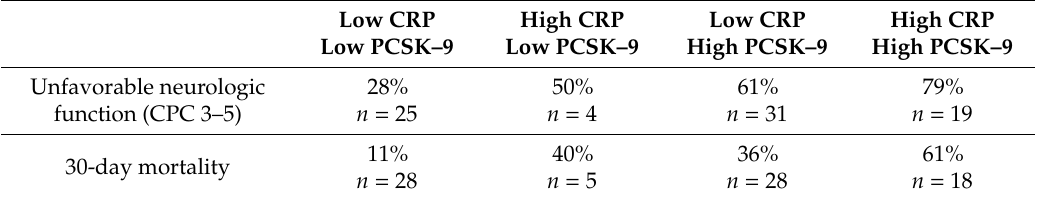
Table 2. Outcome analysis for groups according to PCSK–9 and C-reactive protein